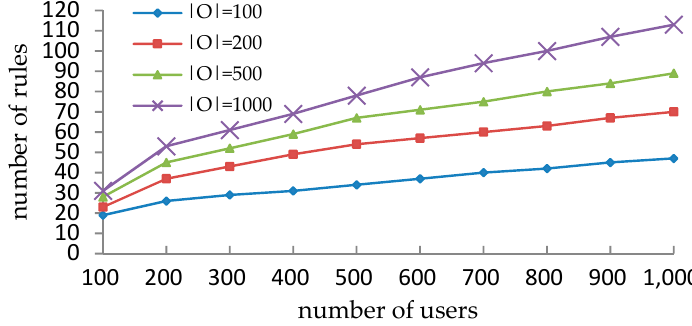
Figure 3. Comparison of rules for different numbers of users and objects.